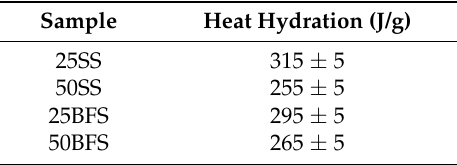
Table 6. Heat hydration values.